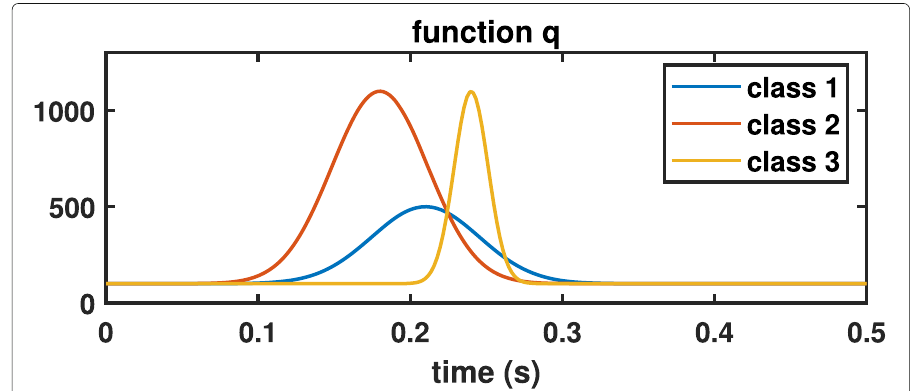
Fig. 6 Functions q for the three classes of simulated stochastic